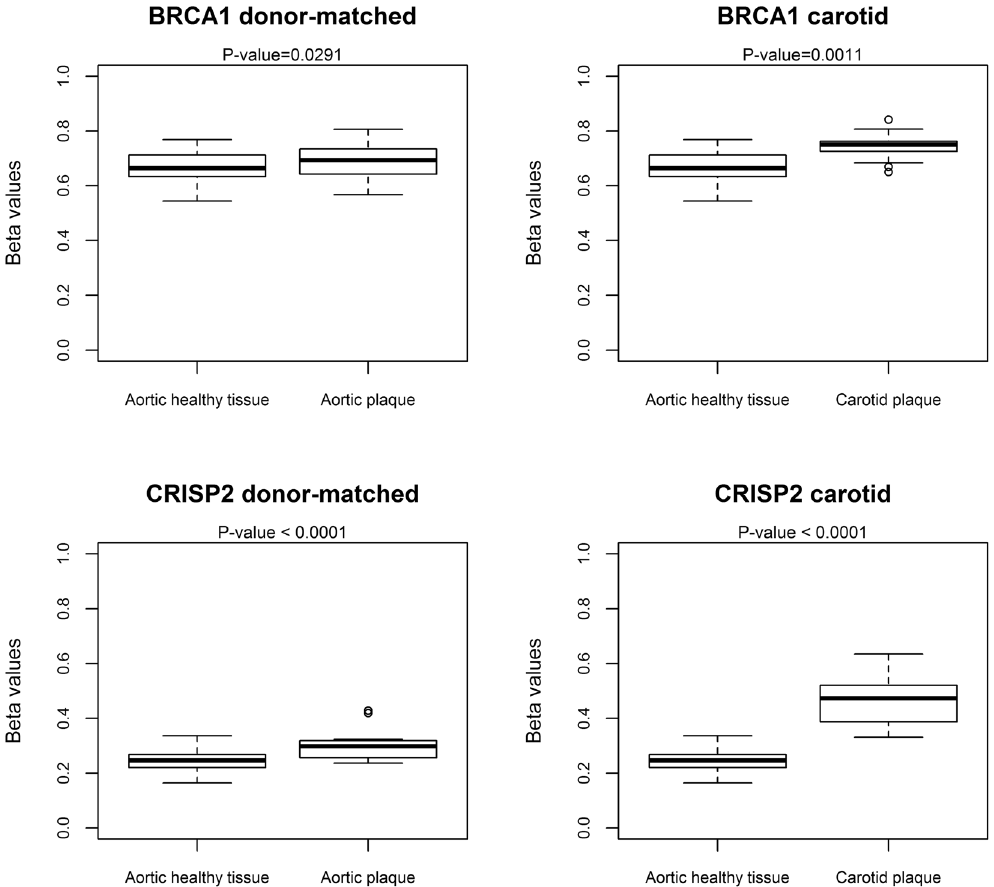
Figure 8. DMRs associated with BRCA1 and CRISP2 in an independent publicly available cohort (Zaina et al . 22 ). The Zaina et al . cohort comprises of 30 donor-matched atherosclerotic plaque tissue samples and 19 carotid plaque samples.